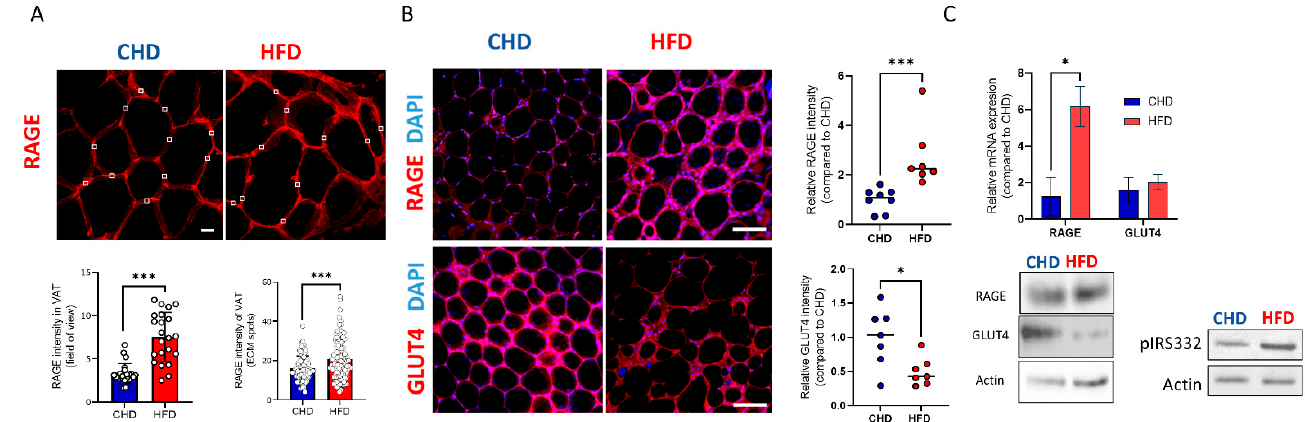
Figure 3. Expression of RAGE, GLUT4, and IRS-1. ( A ) Immunofluorescence staining of RAGE (red) in visceral adipose tissue (VAT) of histological sections from HFD and CHD-fed mice (magnification of ×630, scale bar = 50µm), and intensity quantification of RAGE expression per FOV or by random points of ECM ( B ) Whole mount staining and FOV quantification of RAGE (upper panel) and GLUT4 (lower panel) in HFD (red) and CHD-fed mice (blue), VATs (magnification of ×200, scale bar = 115µm), Cell nuclei are marked by DAPI (blue) ( C ) Quantitative PCR of VAT analyzed from CHD (blue) and HFD-fed mice (red) (n = 4 per group) for RAGE (upper panel) and for GLUT4 (lower panel) (* p < 0.05, *** p < 0.001), significance was calculated by an unpaired Student’s t -test. Western blot analysis of RAGE, GLUT4 and pIRS-1 Ser332 in CHD and HFD-fed mice.